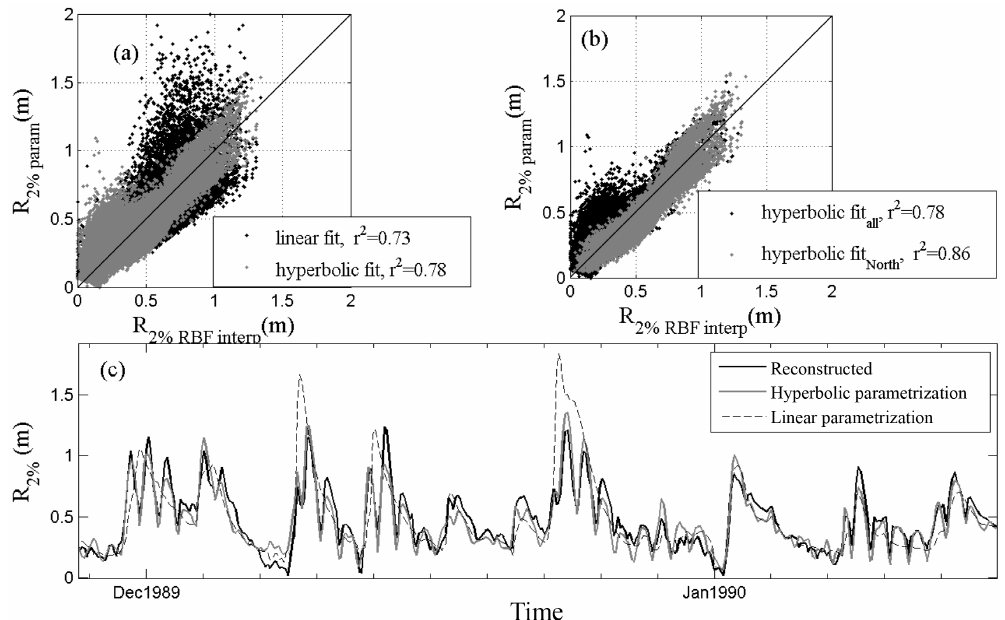
Figure 10. Reconstructed R 2% values obtained from the RBF interpolation correlated against R 2% values obtained from (a) linear vs. hyper- bolic tangent fits; (b) hyperbolic tangent fit to all R 2% values vs. those corresponding to waves approaching from the north (337.5 ≤ θ ≤ 22.5); (c) comparison of a time series section of reconstructed vs. parameterized R 2% values.